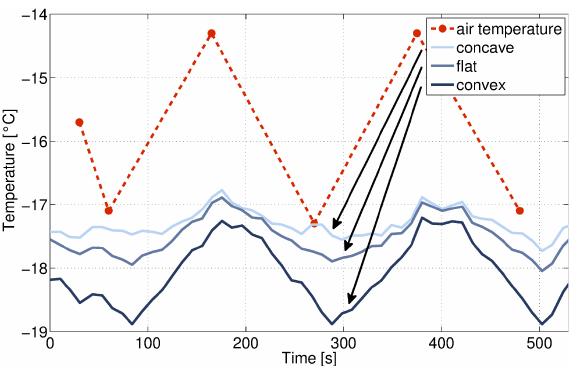
Fig. 8. Snow temperature reacting on changing air temperatures in the cold lab.